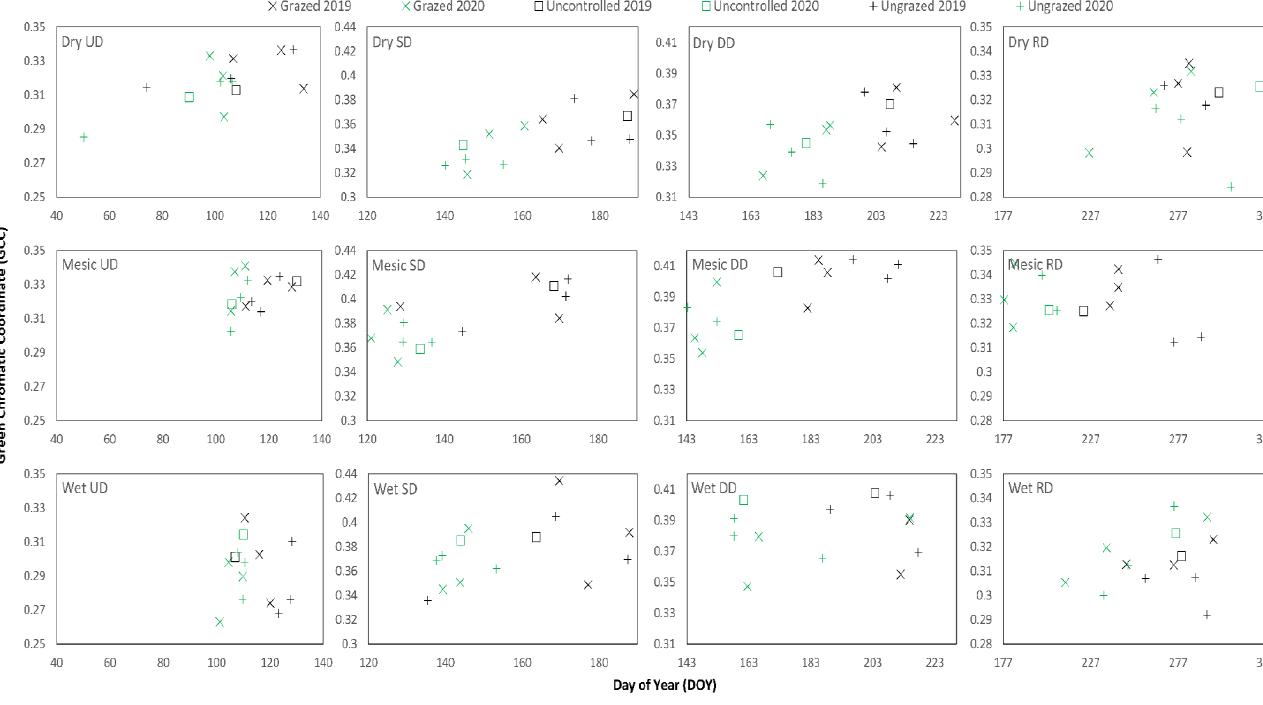
Figure 8. Data for average phenophase day of year values (DOY) in relation to their respective Green Chromatic Coordinate values (GCC) across all meadow treatments. It should be noted that in 2019, all meadows were treated as uncontrolled. In 2020, grazing treatment actually began. Designating meadows as grazed, ungrazed, and uncontrolled in 2019 was done solely to show differences in the groups of meadows across the years. Phenophase stages are upturn date (UD), stabilization date (SD), downturn date (DD), and recession date (RD).